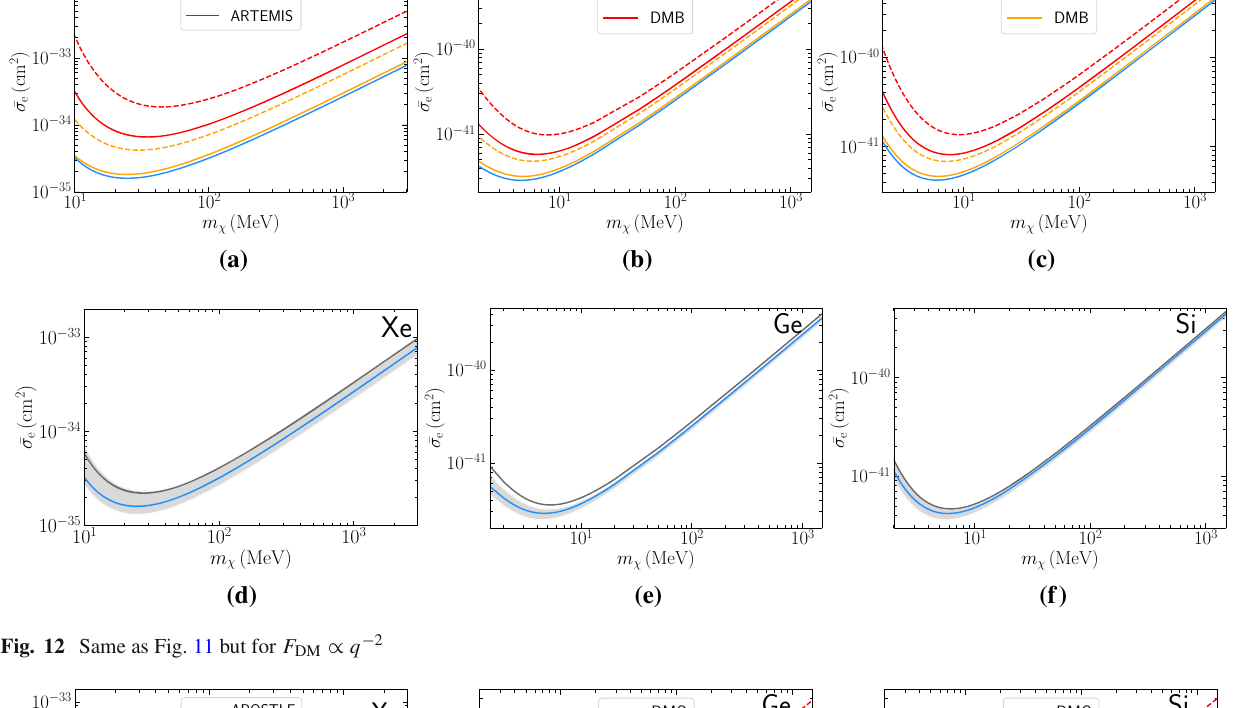
Fig. 12 Same as Fig. 11 but for F DM ∝ q − 2